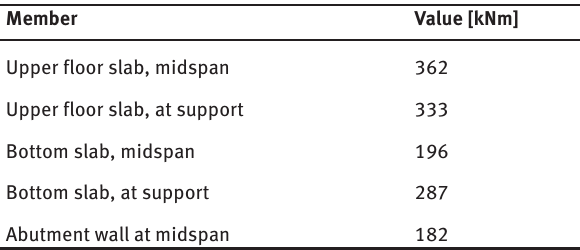
Table 8. Bending moment values used for bridge